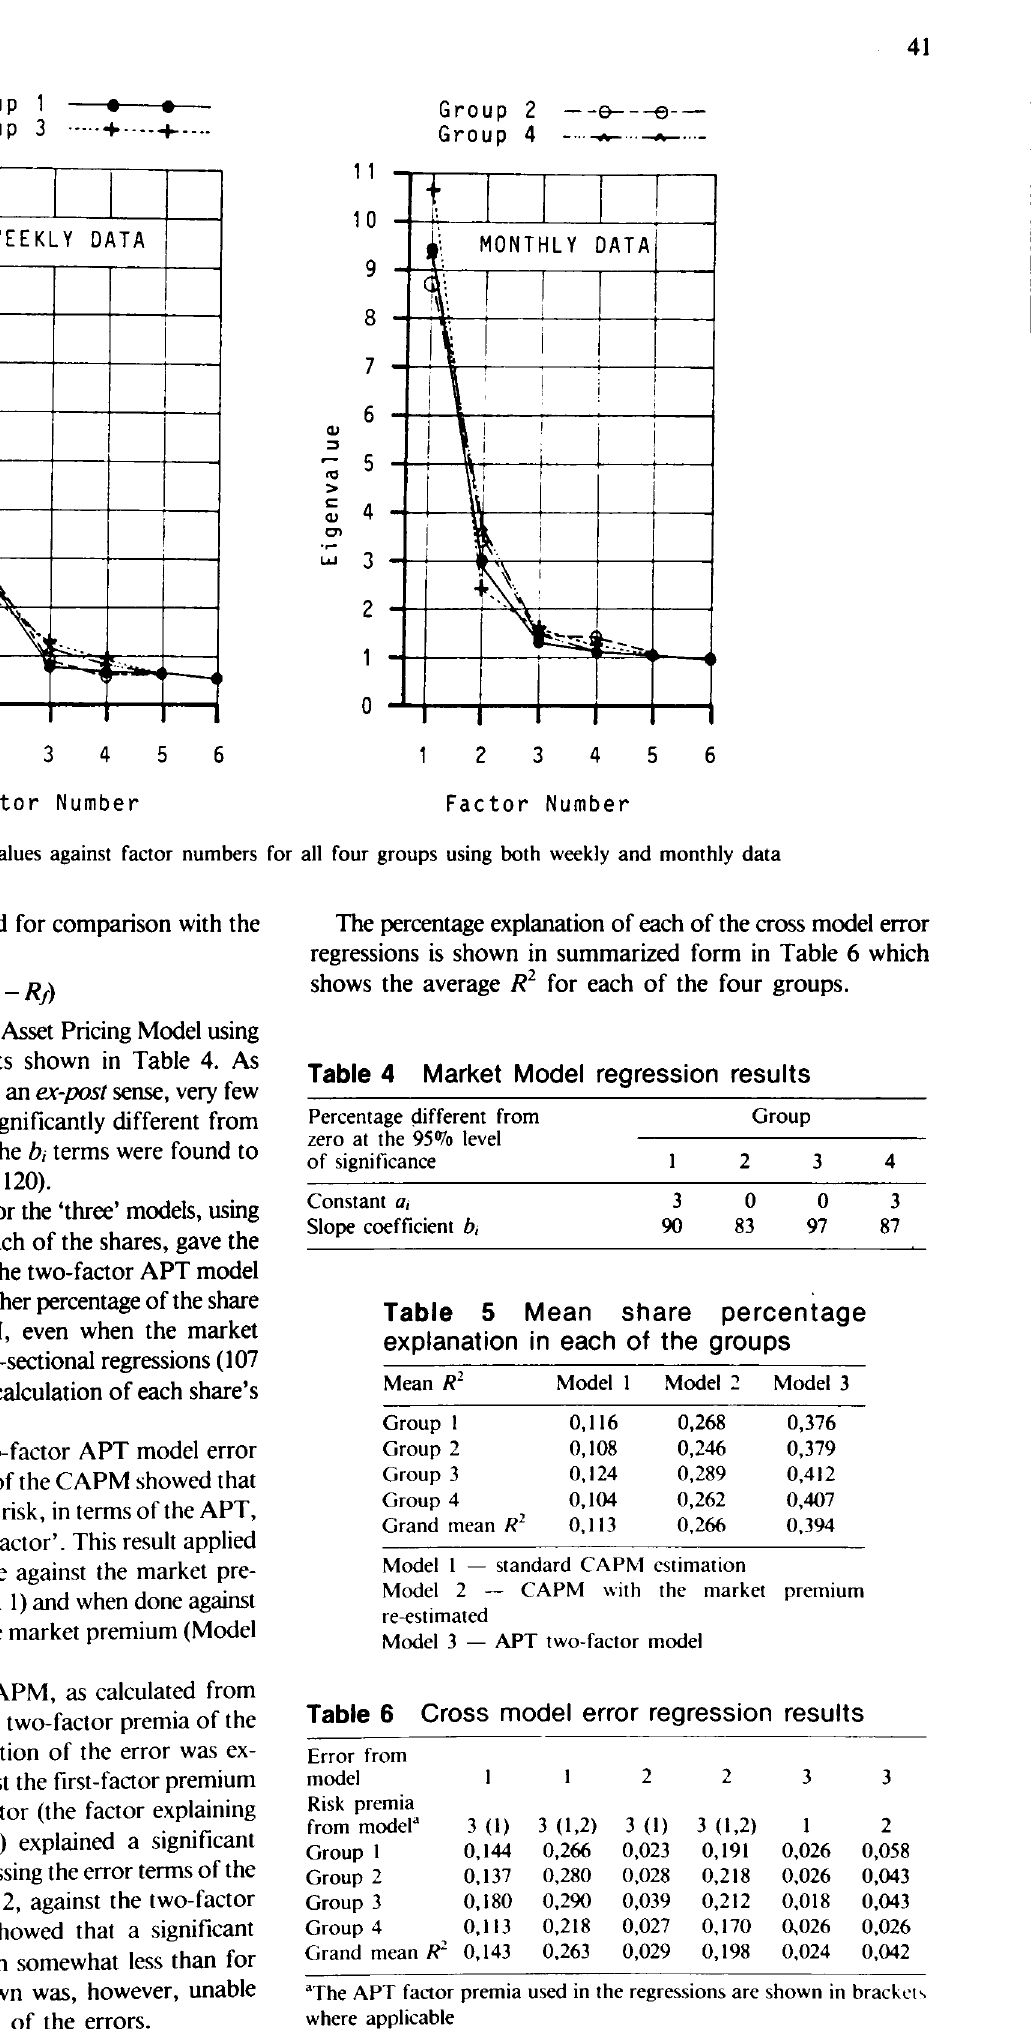
Cross model error regression